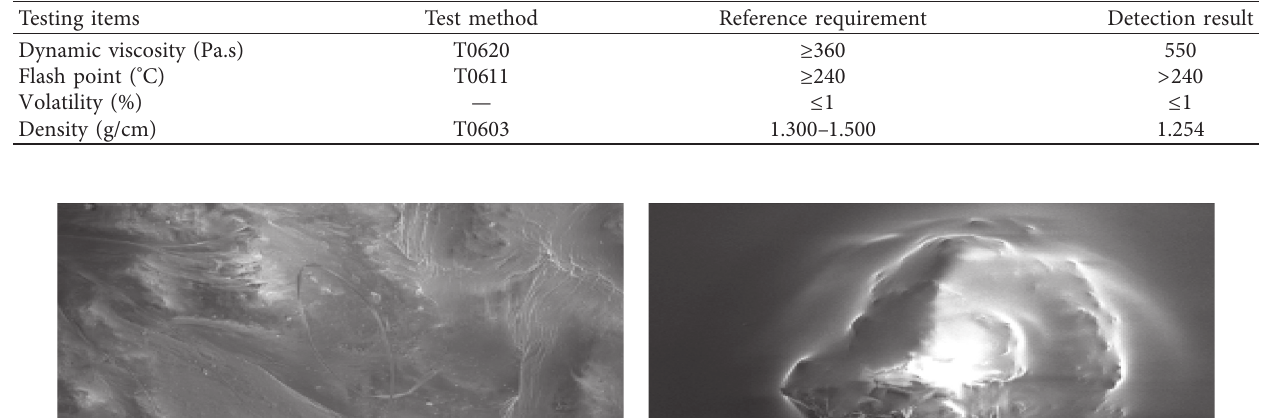
Table 1: Index of plant asphalt extract.